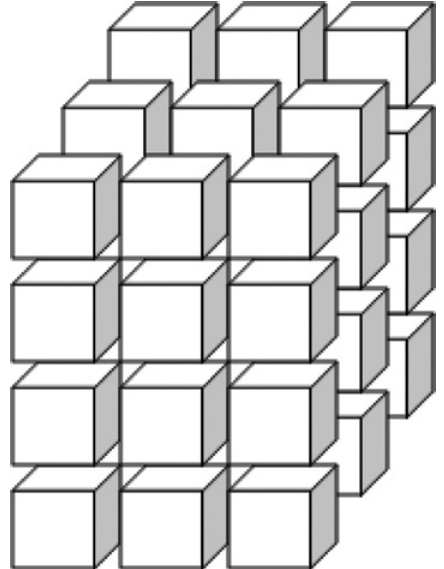
Figure 2: Division of